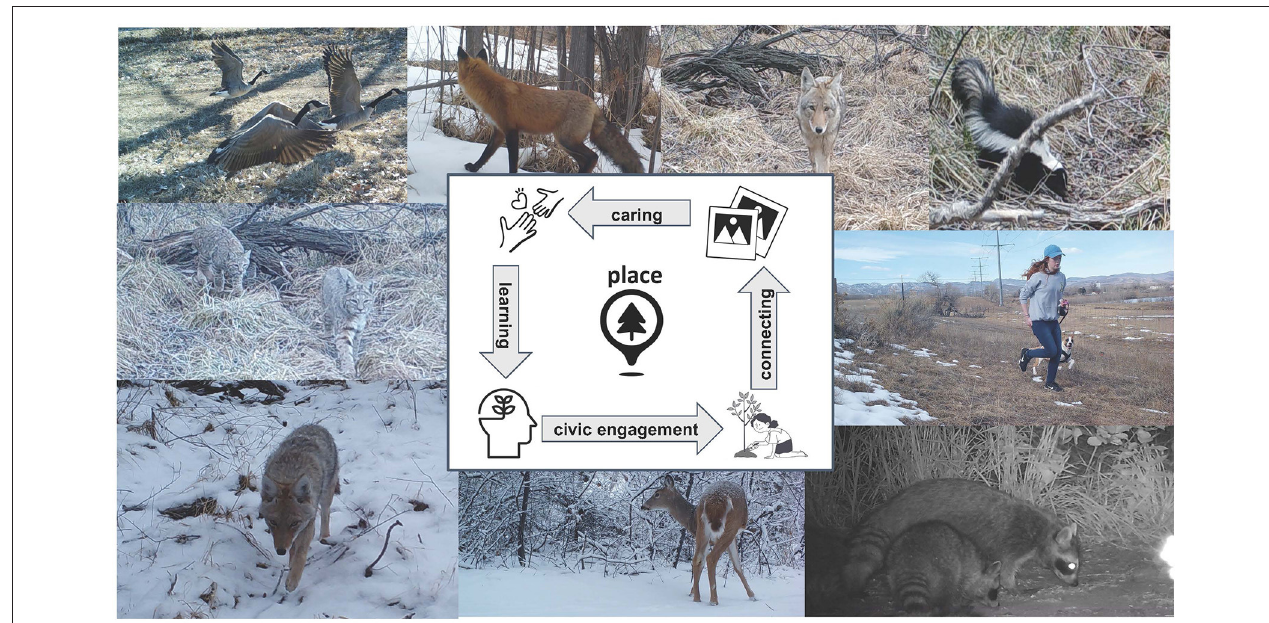
FIGURE 1 | Camera trap photographs allow students to discover “hidden” wildlife, potentially prompting them to connect to, care for, and learn about their local place, often precursors for civic engagement. Images from camera traps were collected by middle school teachers and students in Poudre School District with support from Kevin